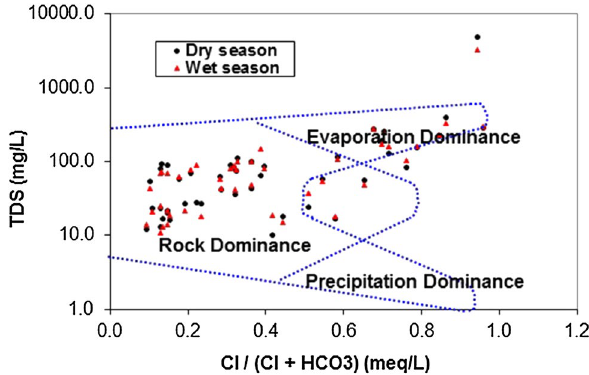
Fig. 4 Gibbs plot of anion